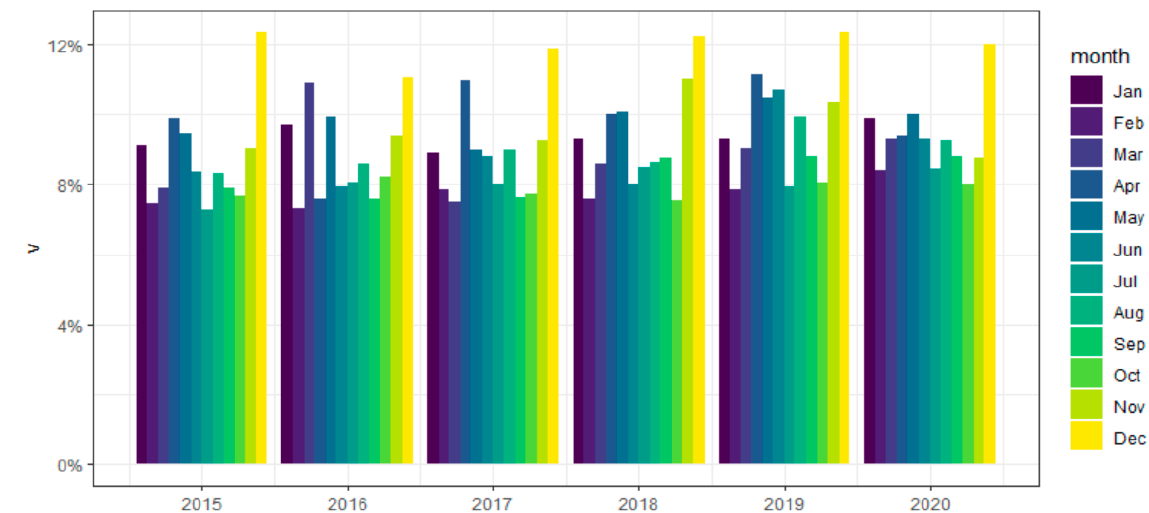
Figure 10. Daily consumption—coef. of volatility in months 2015–2020.